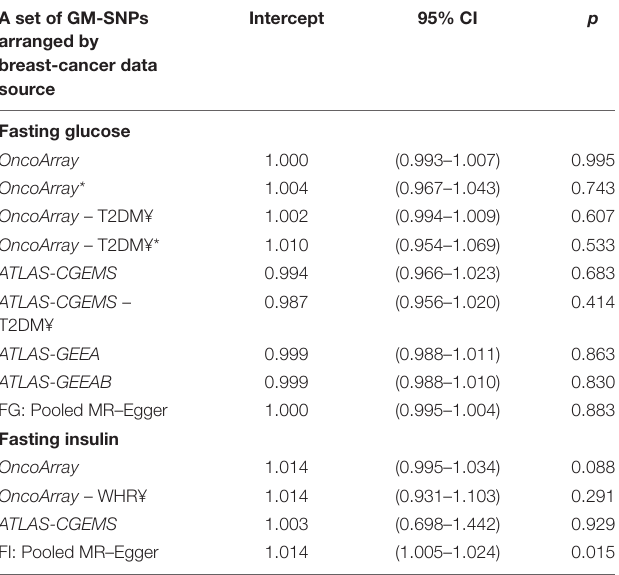
TABLE 3 | Mendelian randomization–Egger test results † . A set of GM-SNPs arranged by breast-cancer data